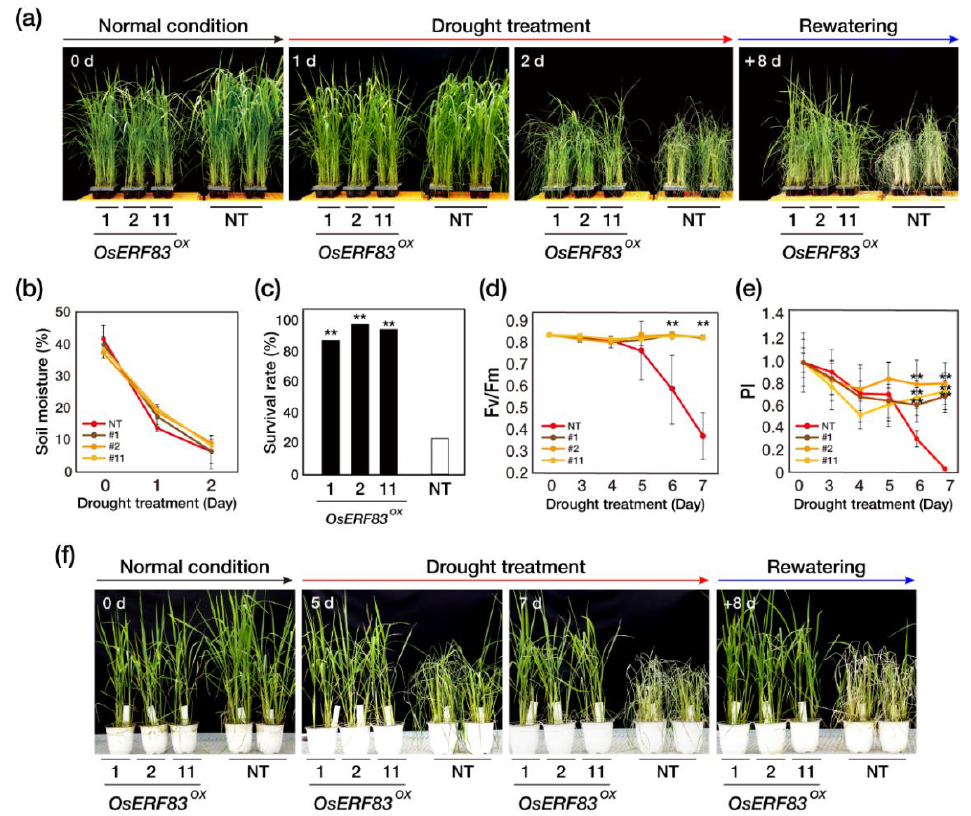
Figure 2. Overexpression of OsERF83 in rice confers drought tolerance. ( a ) Drought tolerance phenotypes of OsERF83 overexpression ( OsERF83 OX ) transgenic plants (lines 1, 2, 11). The 5-week-old plants (0 d) were exposed to drought by withholding water for 2 days and rewatering for 8 days. ( b ) Measurement of soil moisture content (%). Error bars represent the means ± SD ( n = 10). ( c ) The survival rate of the transgenic plants, scored 8 days after rewatering. ( d , e ) Determination of the photosynthetic viability of transgenic and NT plants under drought conditions. At the indicated time point after exposure to drought stresses, the chlorophyll fluorescence (Fv/Fm) ( d ) and performance index (PI) ( e ) of overexpression plants and NT plants were measured. The data represent the mean ± SD ( n = 10 points per independent line of each genotype). ( f ) Drought tolerance phenotypes of OsERF83 OX transgenic plants (lines 1, 2, 11) in big pots. The 6-week-old plants (0 d) were exposed to drought by withholding water for 7 days and rewatering for 8 days. Asterisks (**) indicate statistically significant differences compared with non-transgenic (NT) plants according to a Student’s t -test ** p < 0.001).